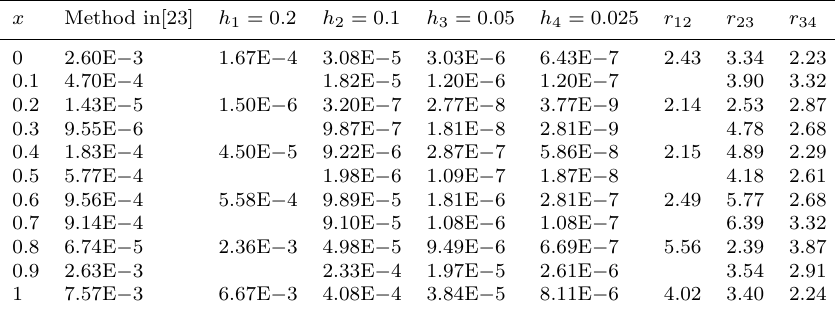
Table 2. The absolute pointwise error and the rate of convergence r for Example 2 x Method in[23] h 1 = 0 . 2